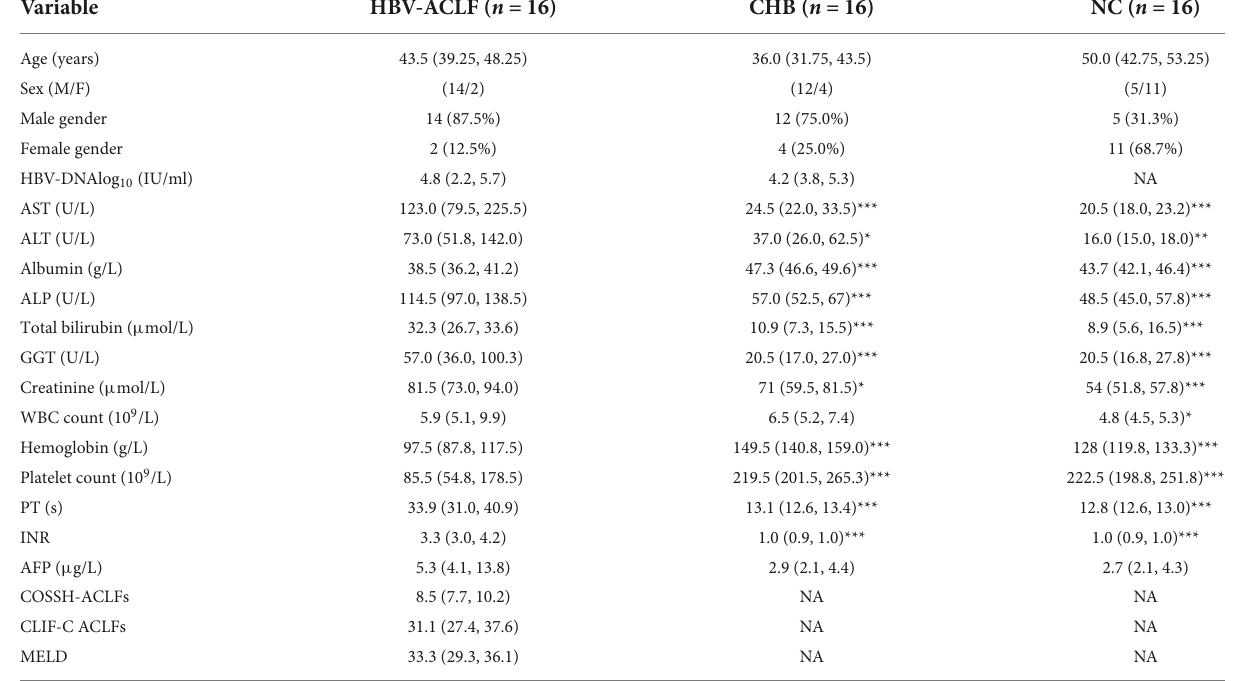
TABLE 1 Baseline participant characteristics.